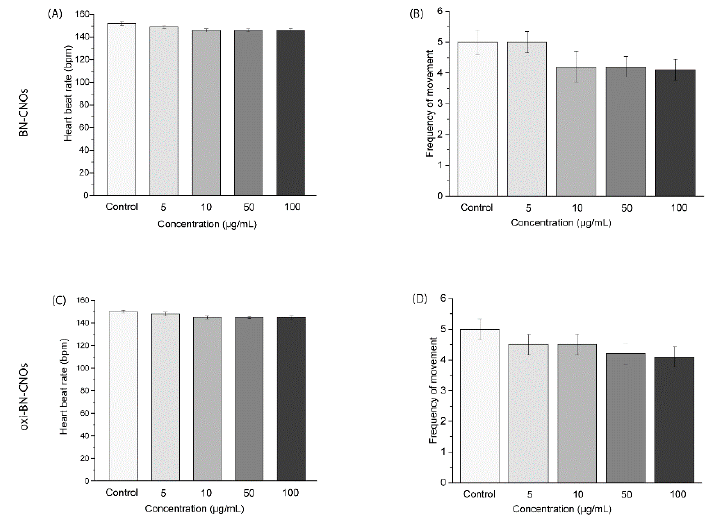
Figure 8. Heart rate ( A – C ) and frequency of voluntary movements ( B – D ) of larvae at 72 hpf ex- posed to different concentrations of BN- and oxi-BN-CNOs.